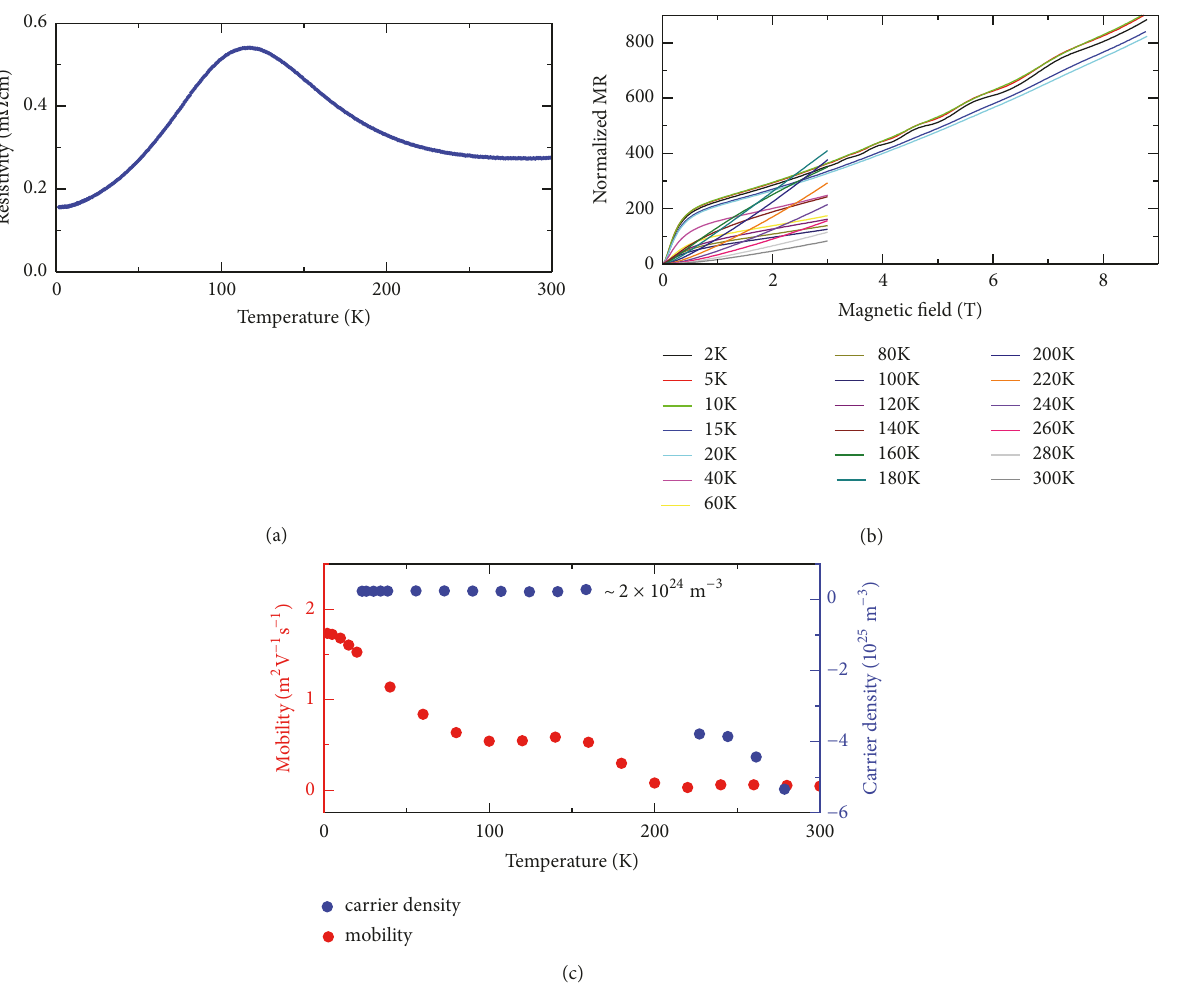
Figure 1: Transport properties of Bi 0.96 Sb 0.04 . (a) Resistivity in zero magnetic field. (b) Magnetoresistance at various temperatures. Quantum oscillations are visible at temperatures of 2, 5, 10, and 15 K. (c) Mobility (red symbols) and carrier density (blue symbols) at different temperatures. In the temperature range 180-220 K we could not extract a reliable value of the carrier